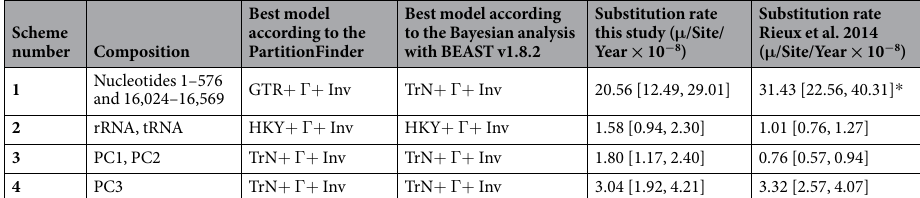
Table 2. The best-fit nucleotide substitution model and substitution rate estimation for each partitioning schemes. GTR = General Time Reversible 33 , HKY = Hasegawa-Kishino-Yano 69 , TrN = Tamura-Nei 34 , Γ = Gamma distribution and Inv = Invariant sites. In all the models the number of gamma categories was set to 4. Substitution rates are the mean with 95% highest posterior density interval. For the comparison, the substitutions rates obtained from Rieux et al . 38 also are presented. * Mutation rate estimated for hypervariable region 1 and 2 (HVR1 +